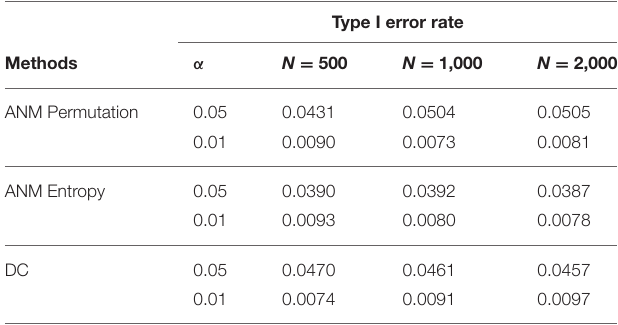
TABLE 2 | Average type 1 error rates of three statistics for testing causation, assuming no association.